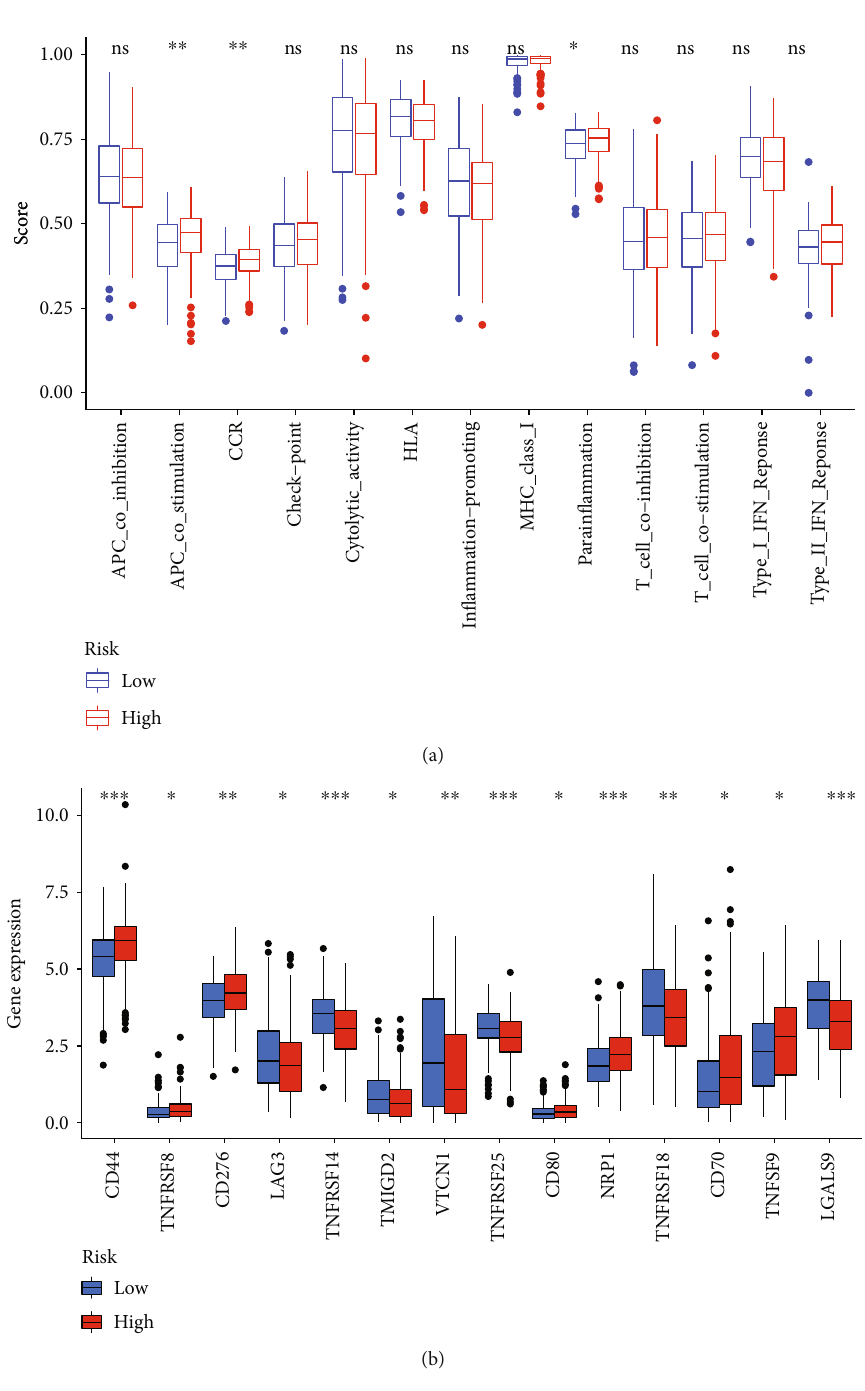
Figure 7: (a) ssGSEA for the relationship between related functions and immune cell subpopulations (b). Expressions of immune checkpoints among low and high CC risk groups. ∗∗∗ p < 0 : 001 , ∗∗ p < 0 : 01 , and ∗ p < 0 : 05